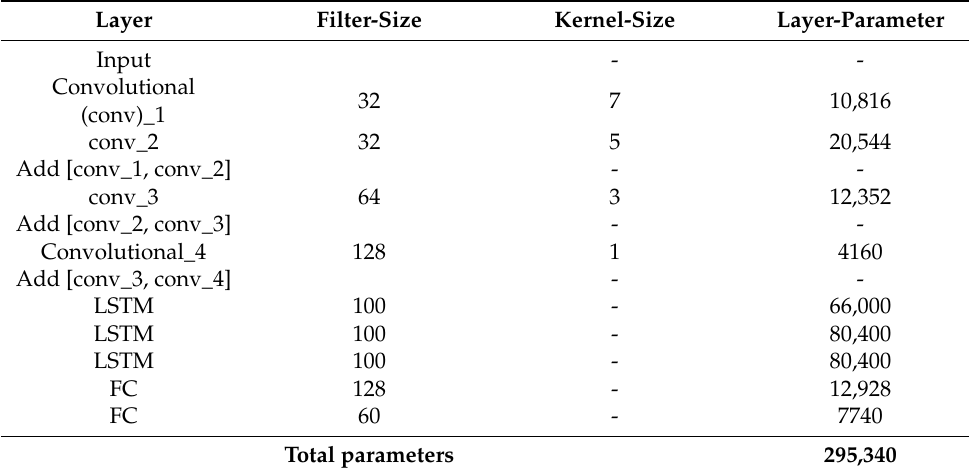
Table 1. The internal architecture of R-CNN and